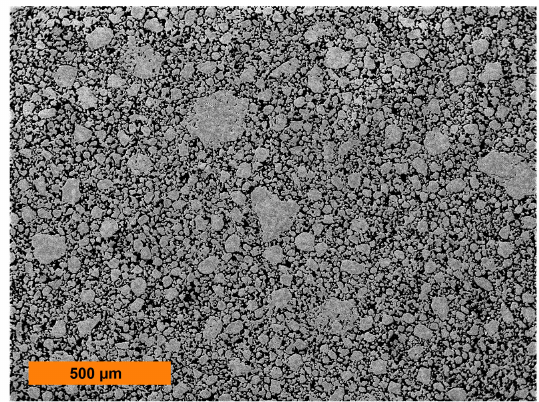
Figure 1. Metallographic section of the mechanically alloyed powder of the new-generation ODS